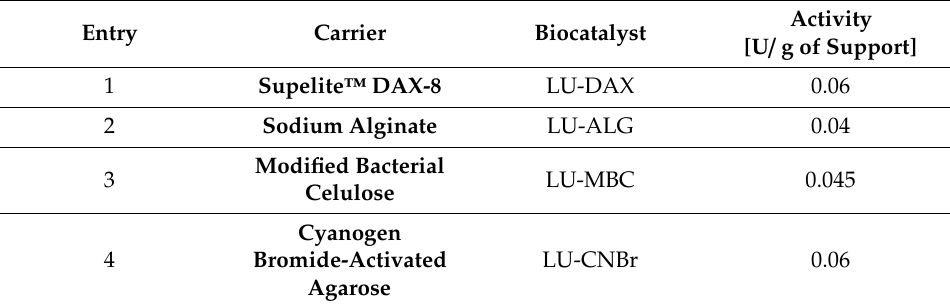
Table 3. Activity of Lecitase ™ Ultra (LU)